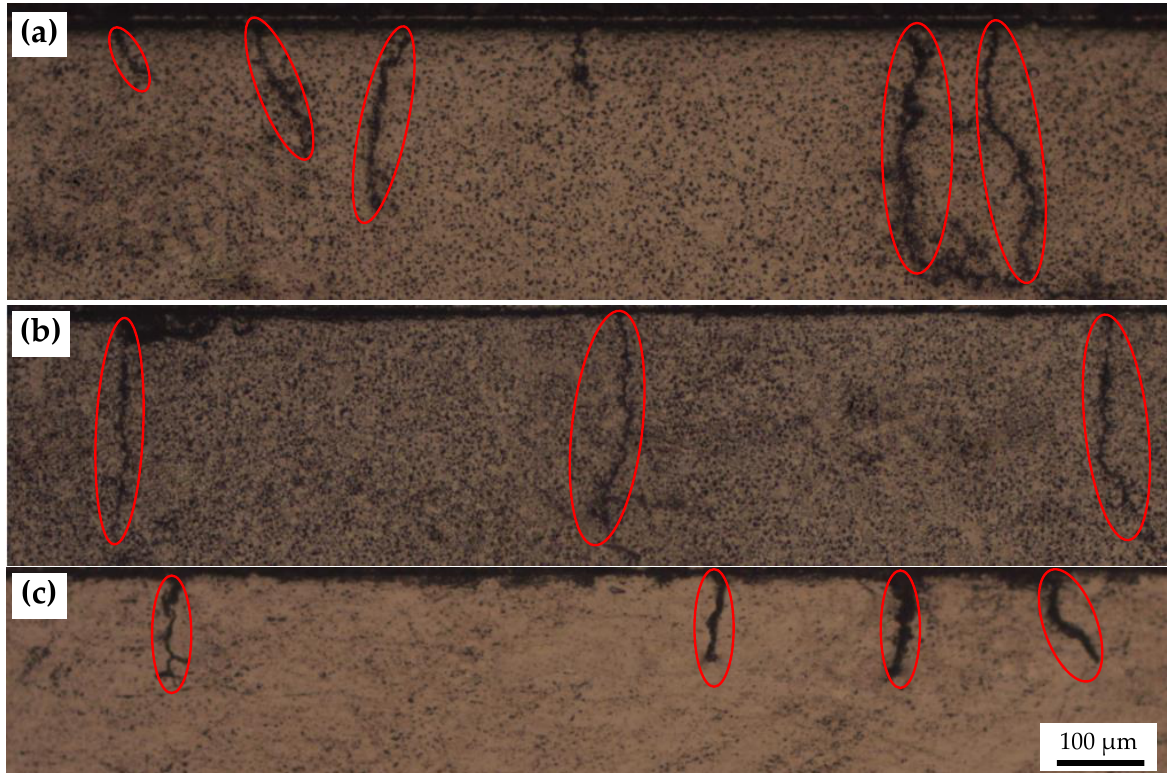
Figure 7. Light micrographs of the cross section of WTC samples after thermal loading. ( a ) As-sintered at 330 MW/m 2 , ( b ) as-sintered at 440 MW/m 2 , and ( c ) as-forged at 440 MW/m 2 . The scale indicated is the same for all graphs.